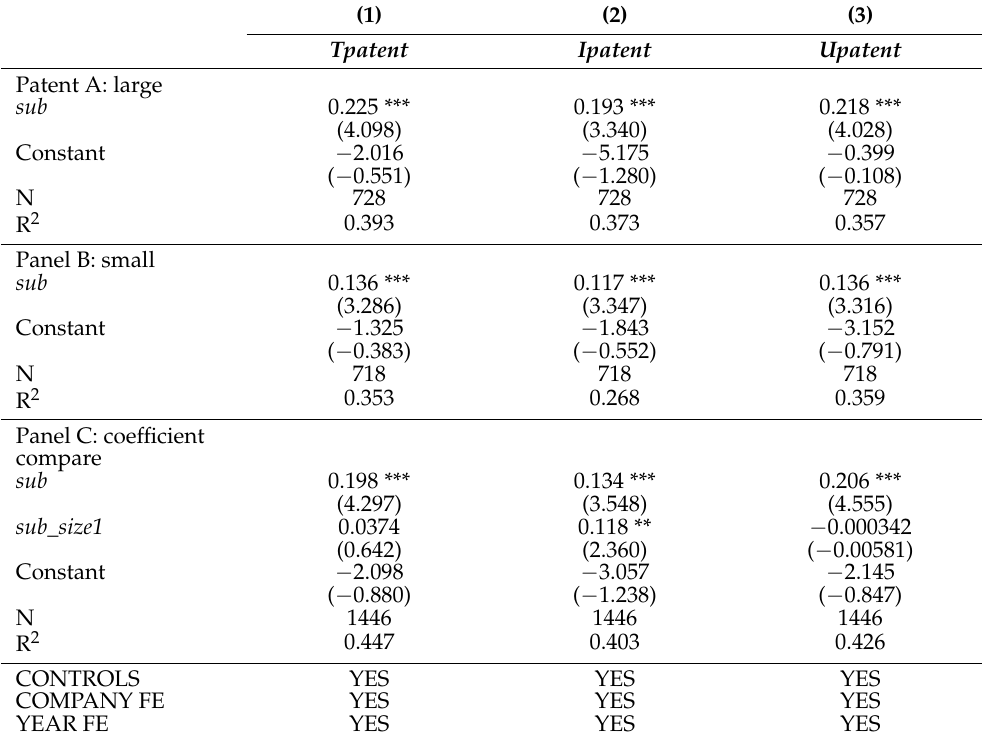
Table 14. Heterogeneity analysis: Enterprise size perspective (quantity of technological innovation).